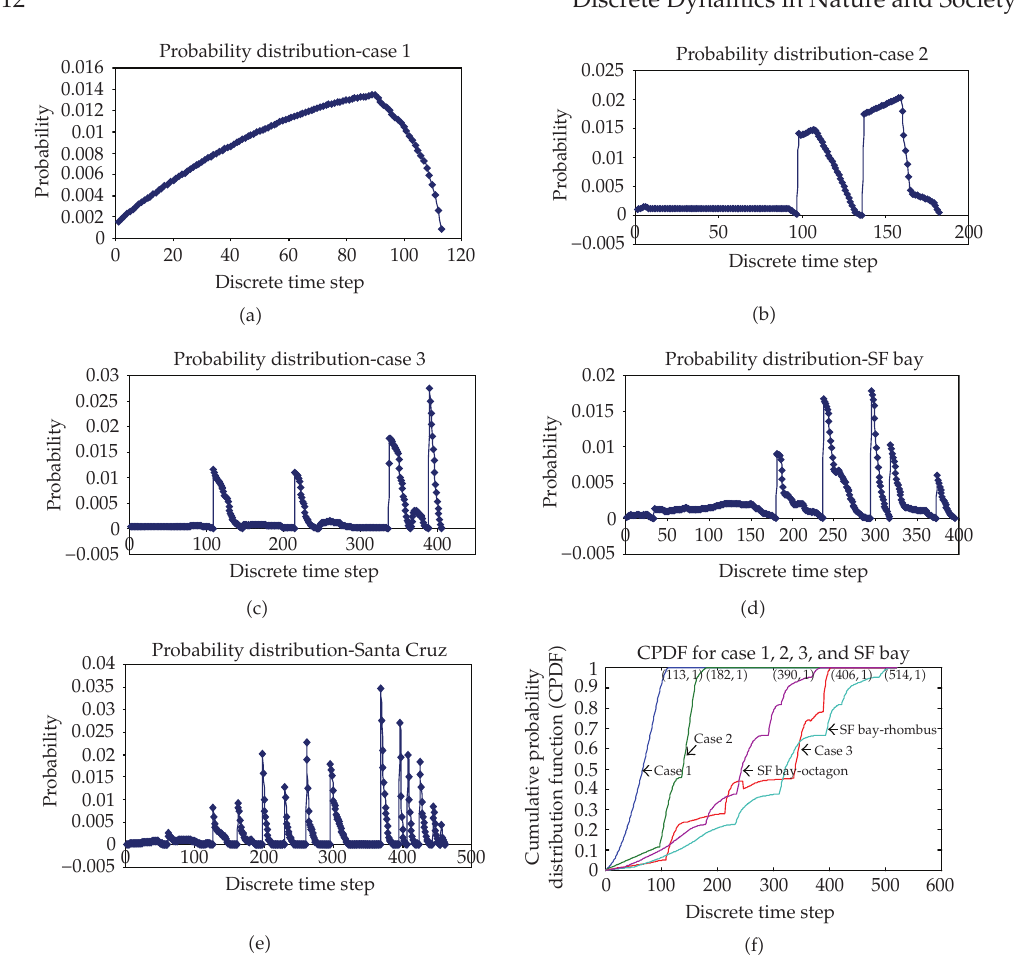
Figure 9: Probability of estimated area flooded at each discrete time step. The flow propagation for the 3 cases is simulated by using rhombus as structuring element, while flow fields for San Francisco Bay and Santa Cruz are simulated with the use of octagon as structuring element. (cid:2) a (cid:3) case 1, (cid:2) b (cid:3) case 2, (cid:2) c (cid:3) case 3,